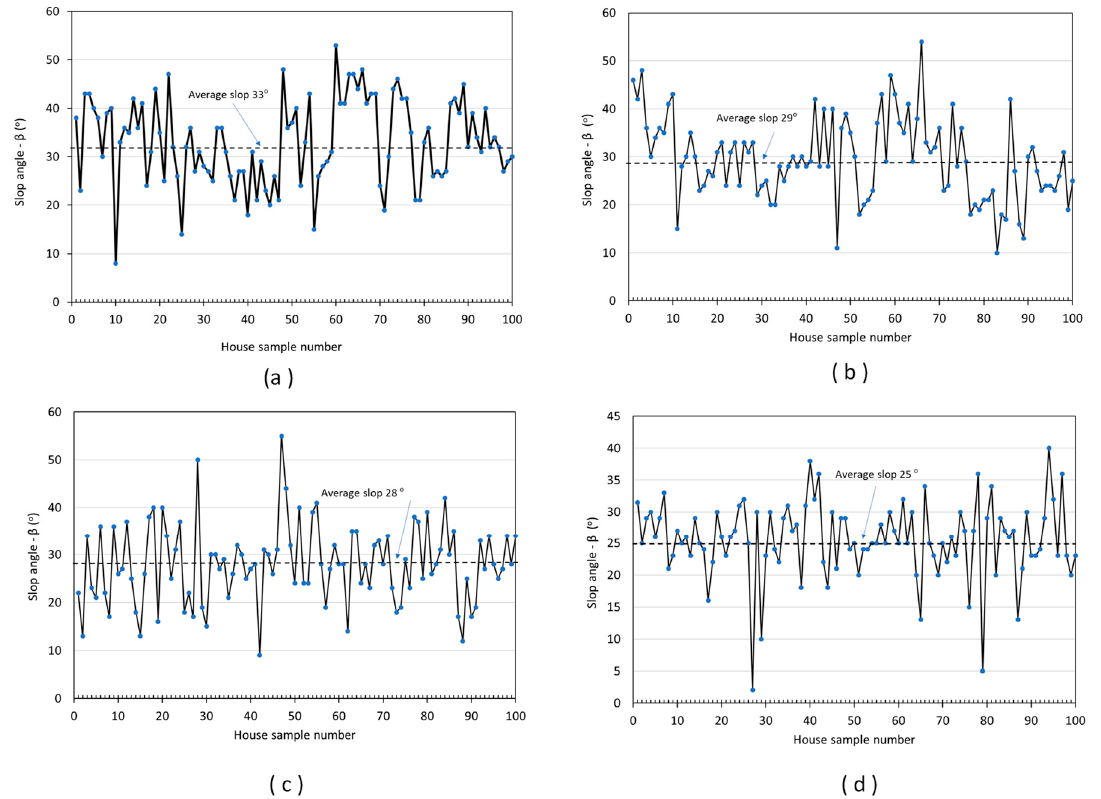
Figure 6. Roof slope angle ( β ) in four suburbs: ( a ) Newtown, ( b ) Redfern, ( c ) Erskineville, ( d ) Rosebery.